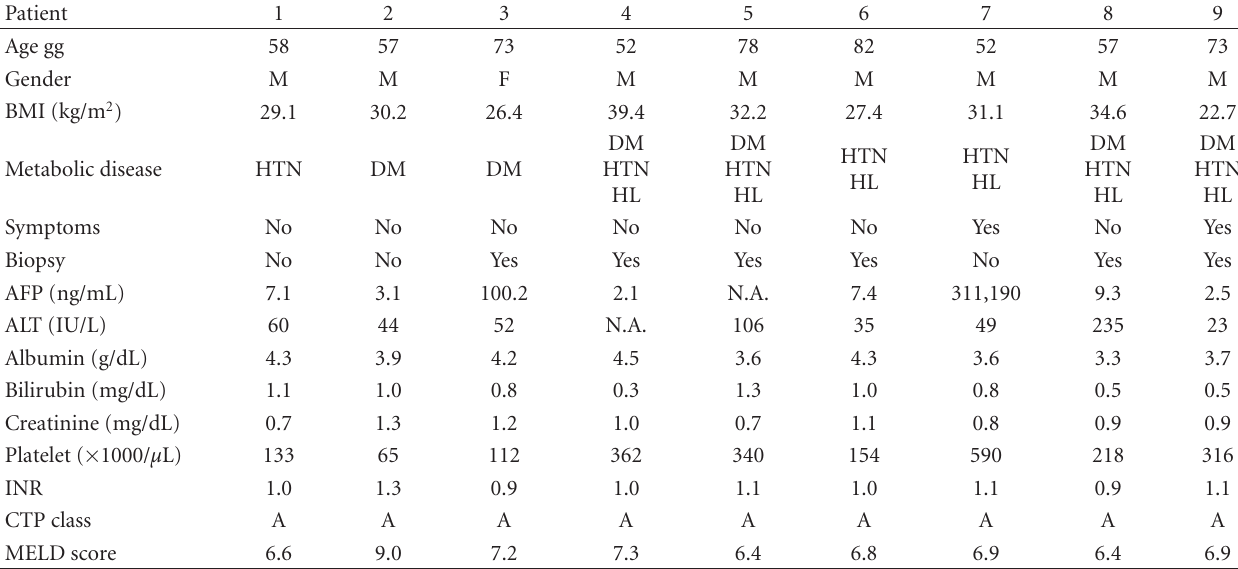
Table 3: Demographic and clinical data.